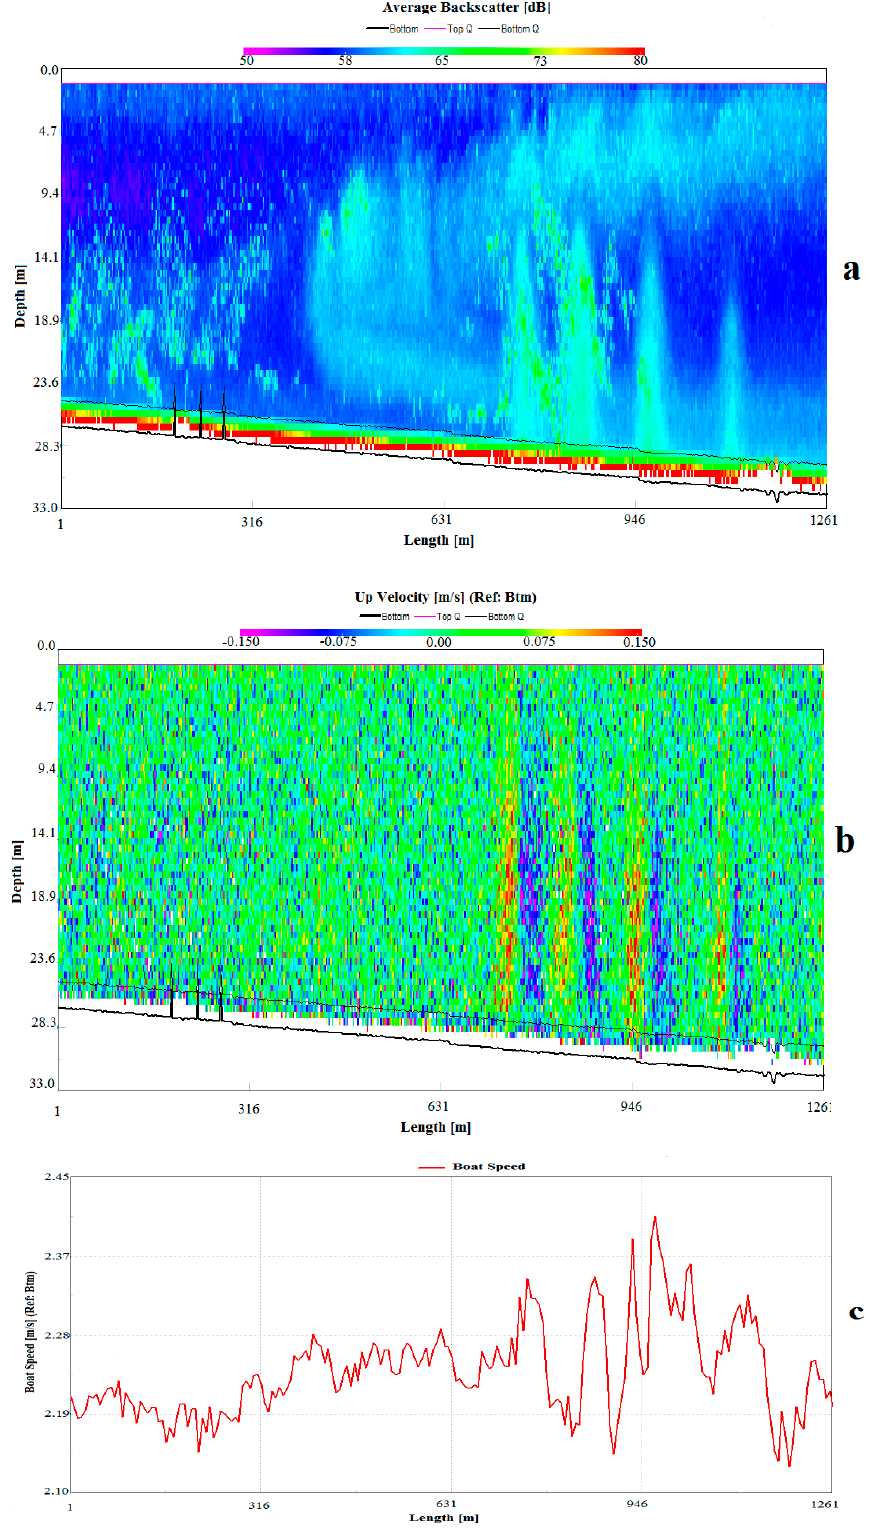
Figure 4. ADCP recordings on a rectilinear spatial section when passing over a train of internal waves: ( a ) picture of echolocation contrasts (acoustic backscatter signal); ( b ) data of vertical current velocity; and ( c ) data of the vessel motion speed relative to the bottom.